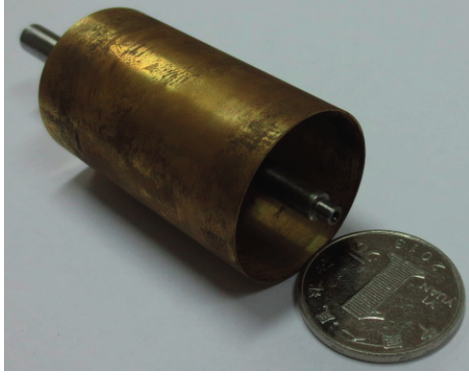
Figure 4. The entity of the cup